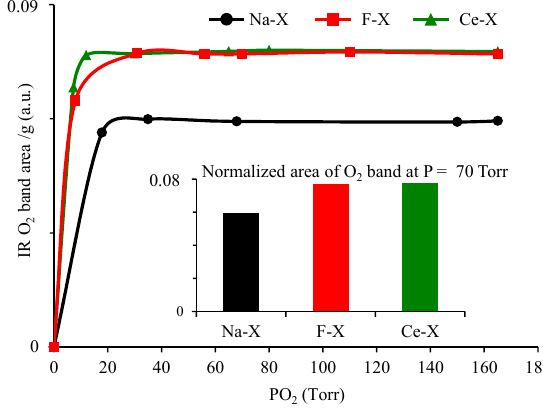
Figure 6. Evolution of O 2 band area of as-synthesized Na-X, fluorinated F-X, and cerium ion exchanged Ce-X zeolites versus applied oxygen pressure at − 196 °C. Inset: normalized area of oxygen band upon adsorbing 70 Torr of oxygen.